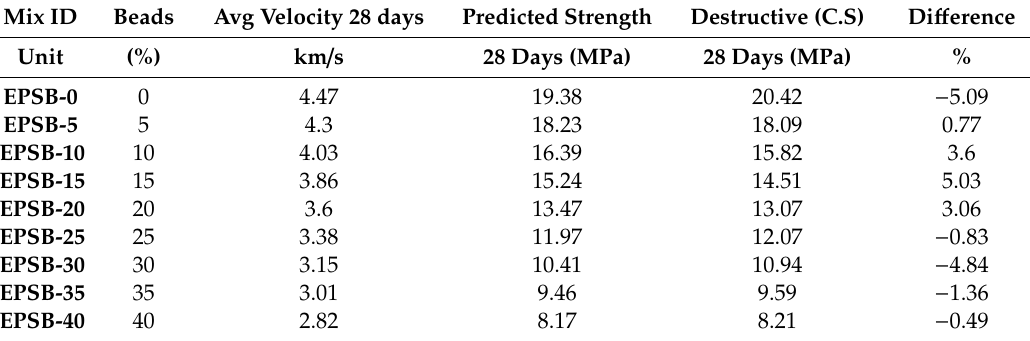
Table 11. Di ff erence between destructive strength and UPV predicted strength at 28